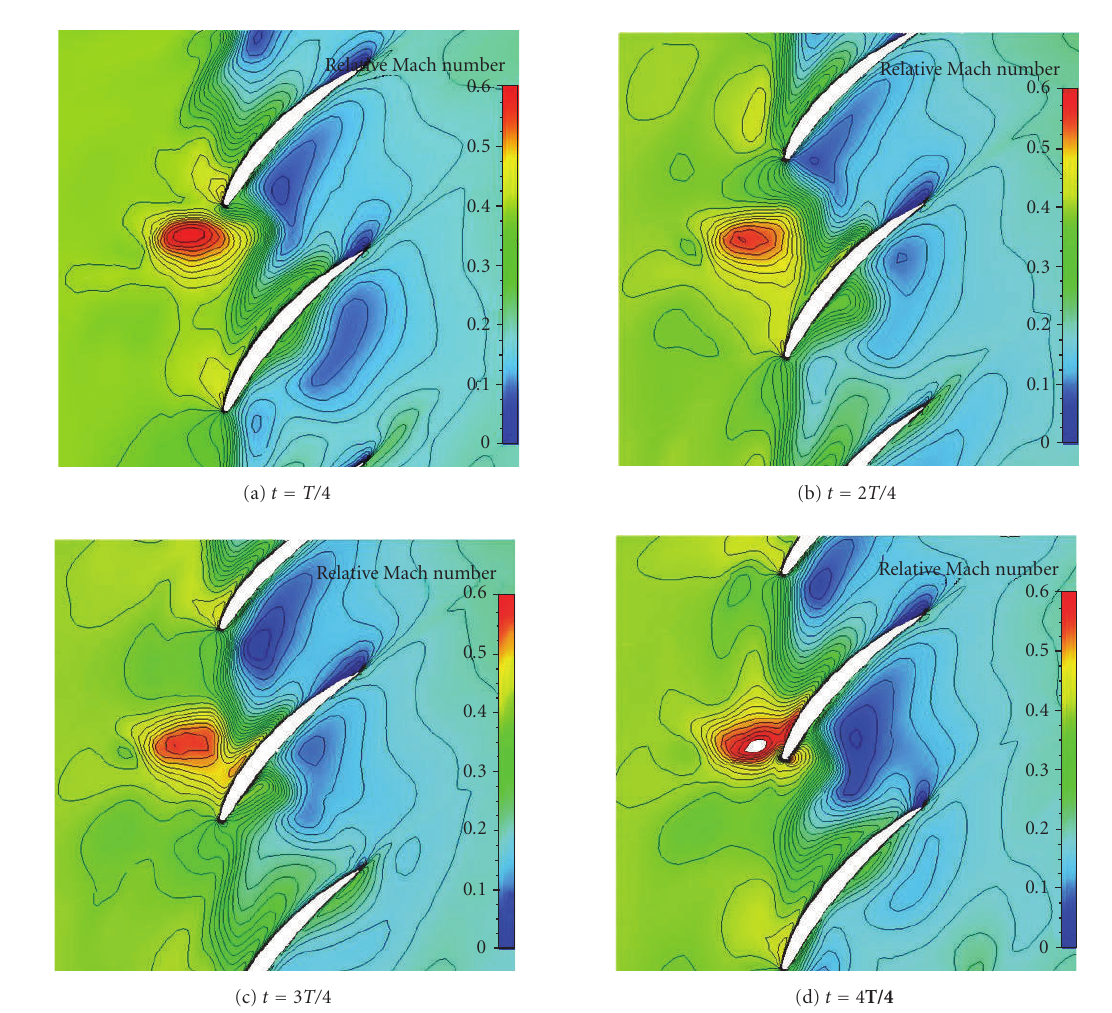
Figure 15: Distribution of relative Mach number at 99% blade span for di ff erent instants during one injector passing